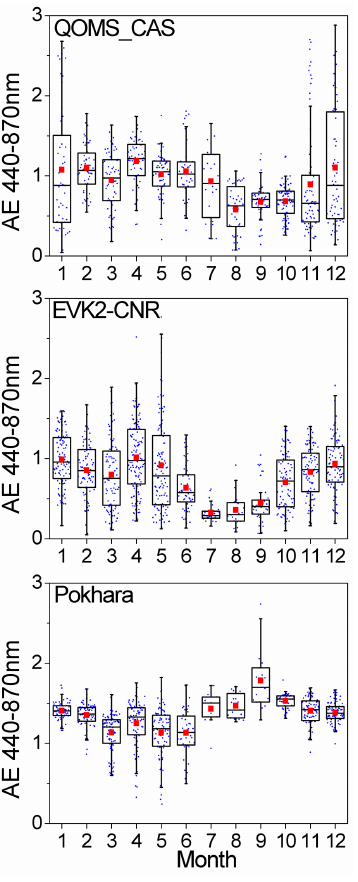
Fig. 6. Box plots of Ångström exponent at 440–870nm at QOMS_CAS, EVK2-CNR and Pokhara. The same symbols are used as in Fig. 3.